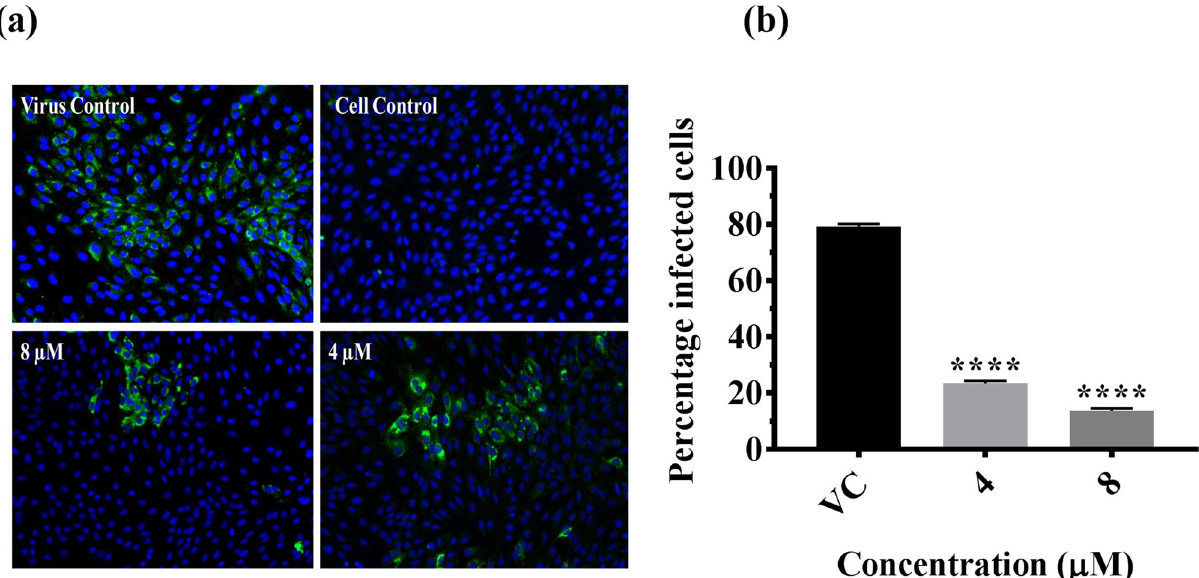
Figure 2. Direct virucidal effect of chebulinic acid (CA) on DENV-2 infection in Vero E6 cells. ( a ) Immunofluorescence staining images of DENV-2 infected Vero E6 cell lines at 72 h post-infection under co-treatment conditions. The cell nucleus was stained with DAPI (blue), and the DENV proteins in the infected cells were stained with FITC (green). ( b ) The quantitative depiction of the infected cell fluorescence levels from the microscopy image by Image J represented as percentage of infected-cells in comparison to the virus control. All the values are expressed as mean ± SEM of three experiments ****P < 0.0001 vs. primarily constituted of chain B and includes the residues of fusion peptide (Fig. 5b,d), wherein the binding is predominantly mediated by non-polar interactions with a total of 9 hydrophobic interactions and an additional 5 hydrogen bonds (SI, Table S1). CA also showed binding to these sites when tested individually during focused docking (data not shown). The third region that CA showed binding to, encompasses EDIII; the associated hinge (the flexible region between DIII and DI); and the DI of chain A (Fig. 5b). CA showed binding to this region in blind as well as focused docking, wherein it bound the residue K295 (conserved across all four serotypes of DENV) and the sugar moiety (Fuc1399) attached to the residue N153 (Fig. 5e). This glycosylation site is also conserved in all the four strains of DENV. In this pocket, CA interacted with E protein through 14 hydrogen bonds and 6 hydrophobic interactions (SI, Table S1). On the other hand, CA did not show binding to the fusion loop, which is located deep